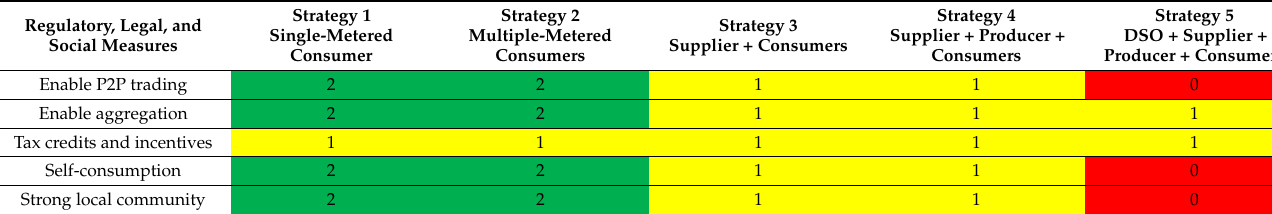
Table 3. Summary of the qualitative impact of regulatory, legal, and organizational measures on EC organizational